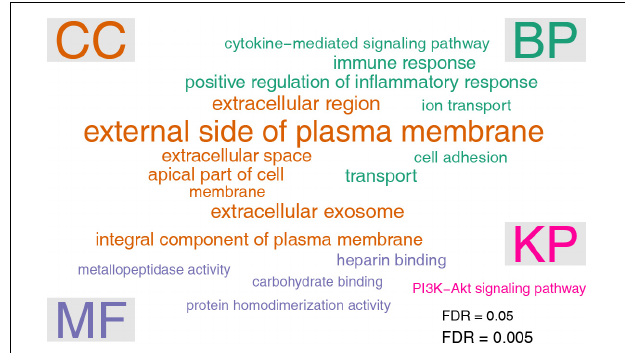
three categories: biological process (BP), cellular component (CC), and molecular function (MF), respectively. Pathway analysis was based on KEGG pathway (KP)